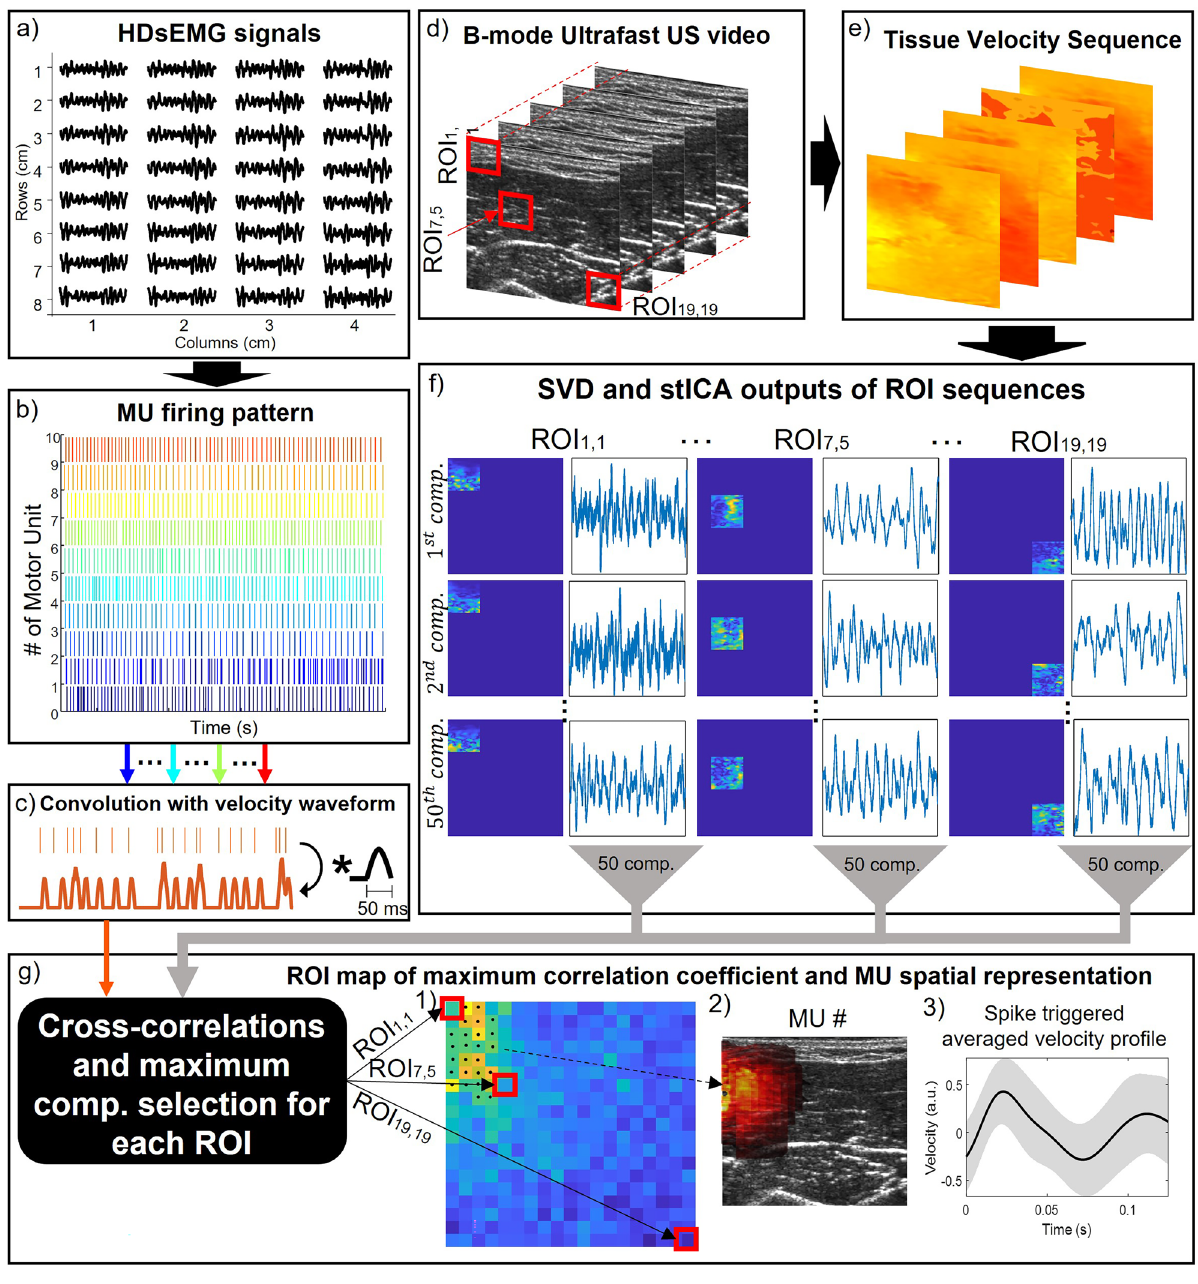
Figure 1. Overview of the proposed algorithm. ( a ) HDsEMG signals of a grid of electrodes. ( b ) Decomposed MU firing pattern from HDsEMG signals. ( c ) Generation of the train of MU displacement velocities through the convolution of the MU firing pattern with the synthetic velocity profile. ( d ) Ultrafast US B-mode sequence with 3 examples of ROI used in the analysis. ( e ) Tissue Velocity Sequence estimated using 2D autocorrelation approach. ( f ) Output of the Singular Value Decomposition and spatio-temporal Independent Component Analysis of the three example ROIs with 50 components (comp.) each composed by a time course (temporal component) and a correspondent image (spatial component). ( g ) Integration between EMG and US variables: cross-correlations between all the temporal components of the tissue velocity sequence of the ROIs and the synthetic train of MU displacement velocities, and example outcome for a single MU. (1) Map of maximum correlation coefficient of all the ROIs (19 × 19). The algorithm extracted the component with the maximum correlation within ± 20 ms time lag for each ROI. The selected ROIs (cluster) are highlighted with black dots. (2) heatmap of the MU spatial representation in US images extracted summing the spatial components of the most correlated ROIs in the coefficient map (black dots); (3) spike triggered averaged velocity profile (black solid line) and its standard deviation (grey